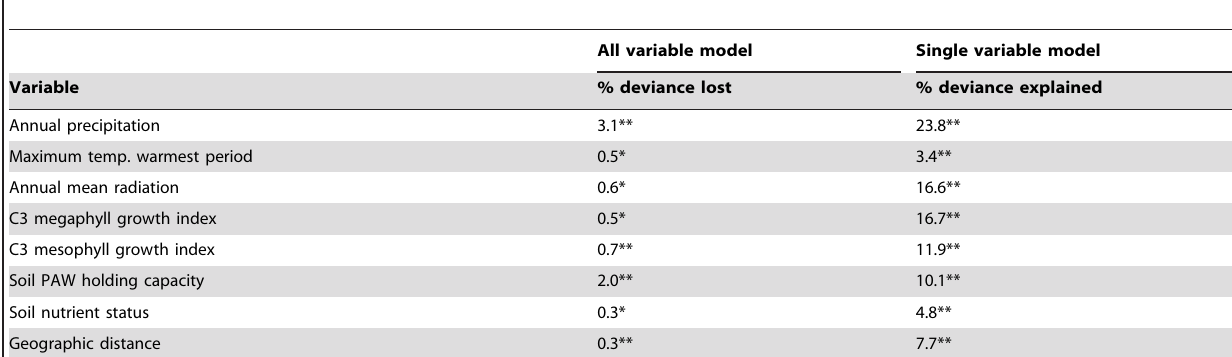
Table 2. Variable contribution to the Generalised Dissimilarity Model of pairwise community compositional dissimilarity for plants in the Australian Wet Tropics.